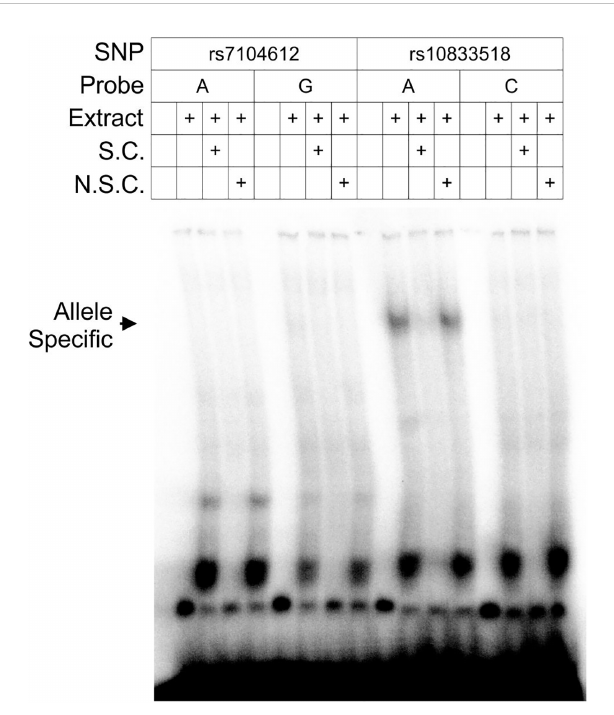
FIGURE 2 Gel shift assay demonstrates a protein-nucleic acid complex speci fi c to the risk allele of rs10833518. Nuclear extract was obtained from U-937 histiocytic lymphoma cells and complexed with 35-bp radiolabeled probes for both alleles of the highest-association risk SNPs, rs7104612 and rs10833518. S.C., speci fi c competitor, an unlabeled probe of the same sequence at 50× concentration. N.S.C., non-speci fi c competitor, an unlabeled probe of scrambled sequence at 50×